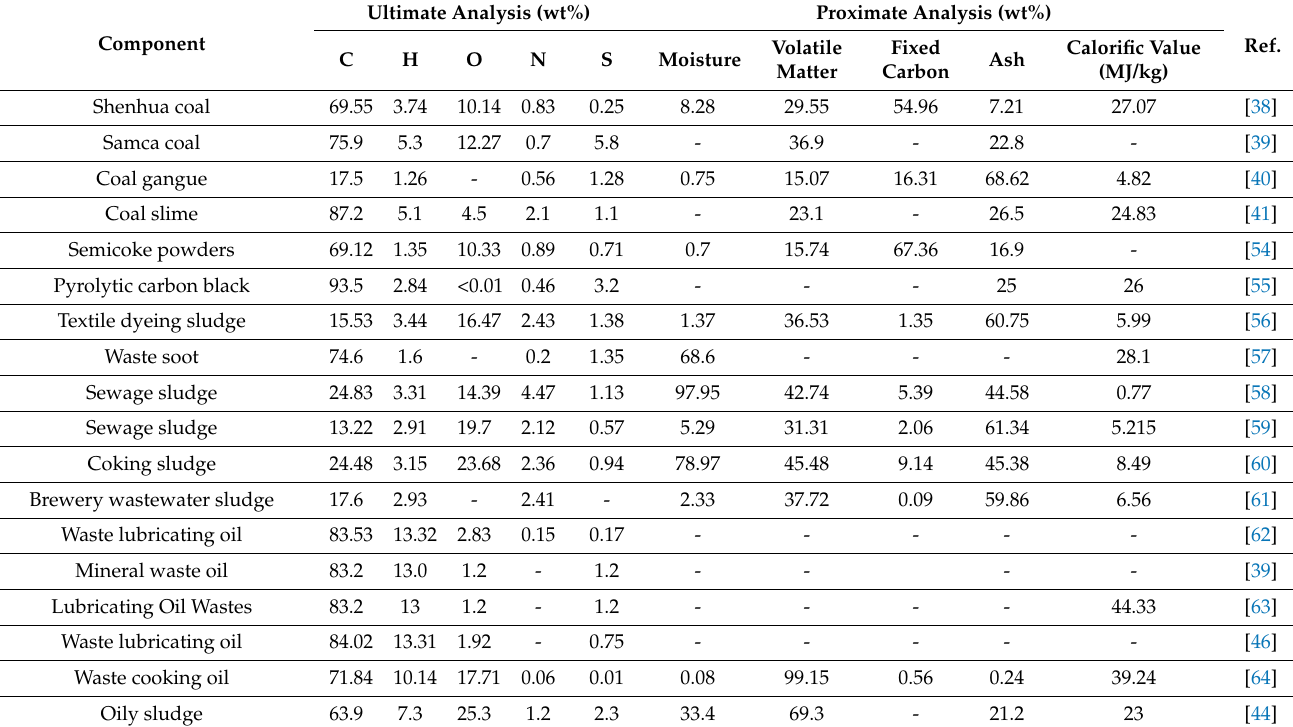
Table 1 provides a list of typical components used to create fuel slurries and blends. Table 1. Properties of the components used for the preparation of fuel mixtures.